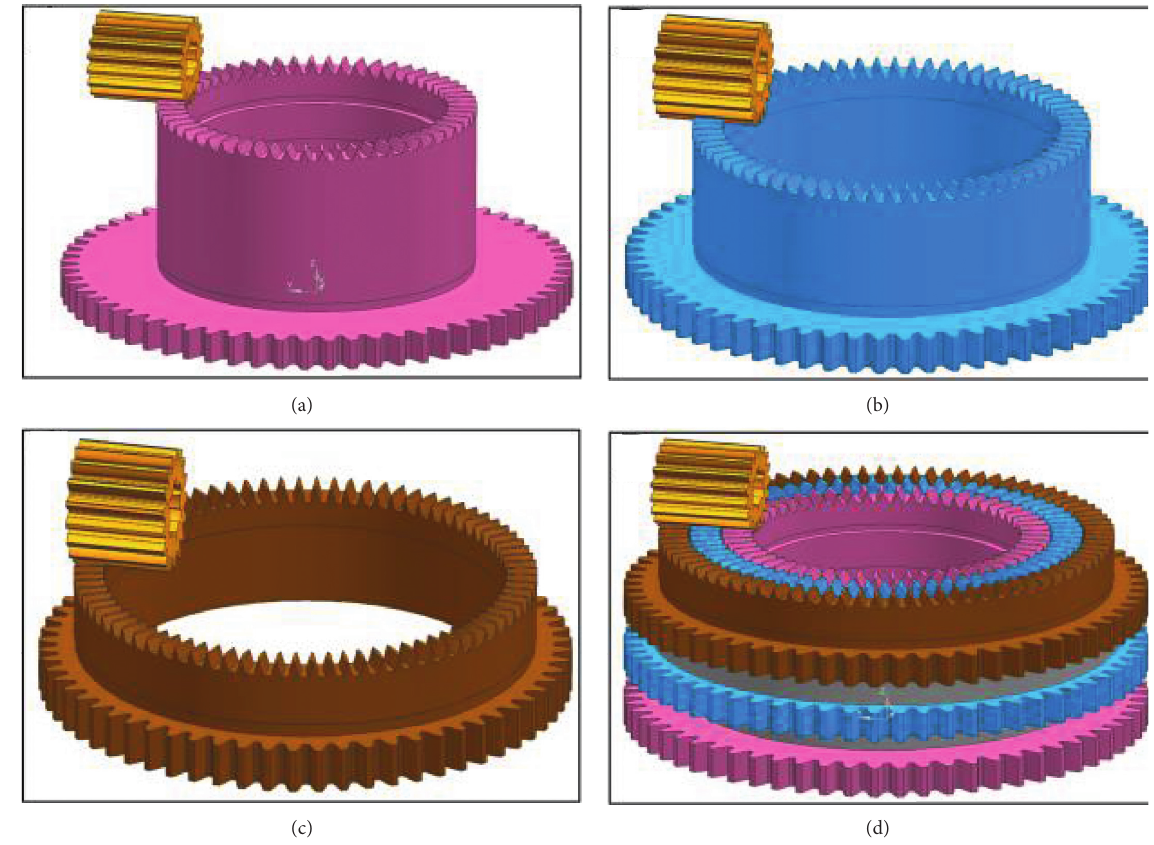
Figure 1: Model of multistage face gear pair with double crown configuration. (a) Level 1 face gear entity. (b) Level 2 face gear entity.